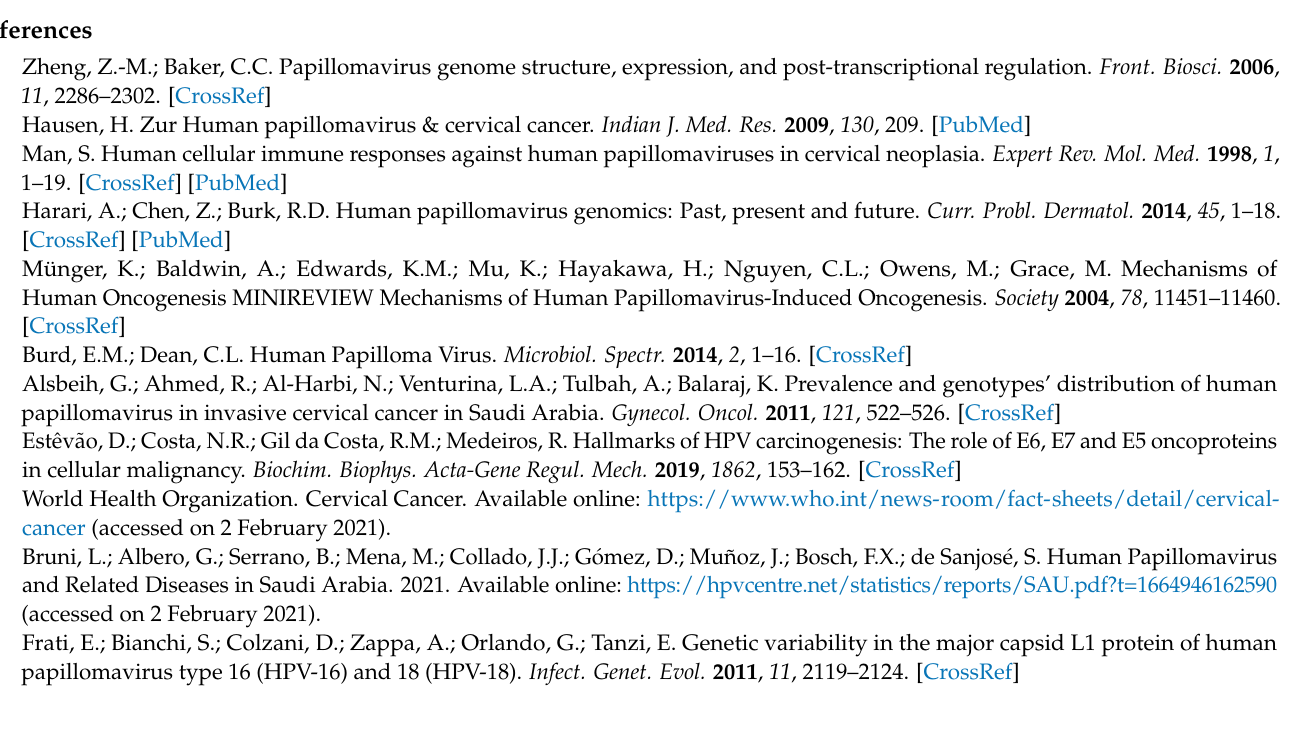
mutations observed in the Saudi population. Table S3. Cervical Cancer association with HPV16 E7 mutations observed in the Saudi population. Table S4. Cervical Cancer association with HPV16 L1 mutations observed in the Saudi population. Table S5. HPV 16 E6 mutations distributed by histology, cytology and SCC grades. Table S6. HPV 16 E7 mutations distributed by histology, cytology and SCC grades. Table S7. HPV 16 L1 mutations distributed by histology, cytology and SCC